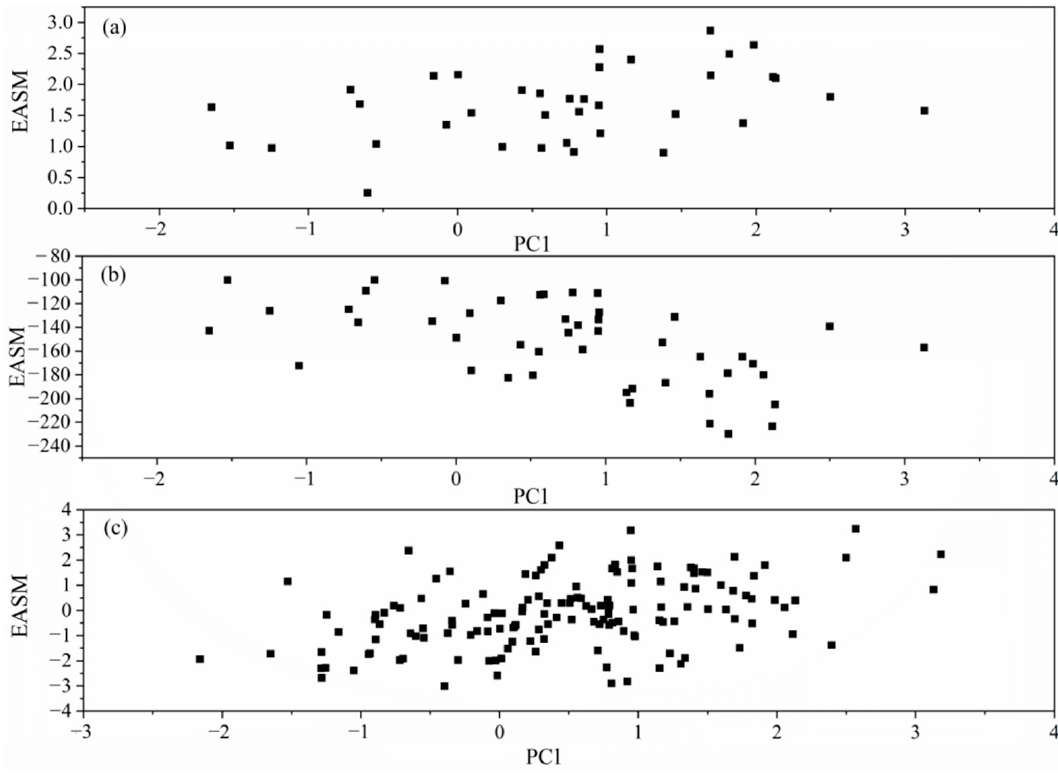
Figure 6. PC1 and East Asian summer monsoon (EASM) indices scatter plot ( a ) Lau [33], ( b ) Guo [32], and ( c ) Wang [31].